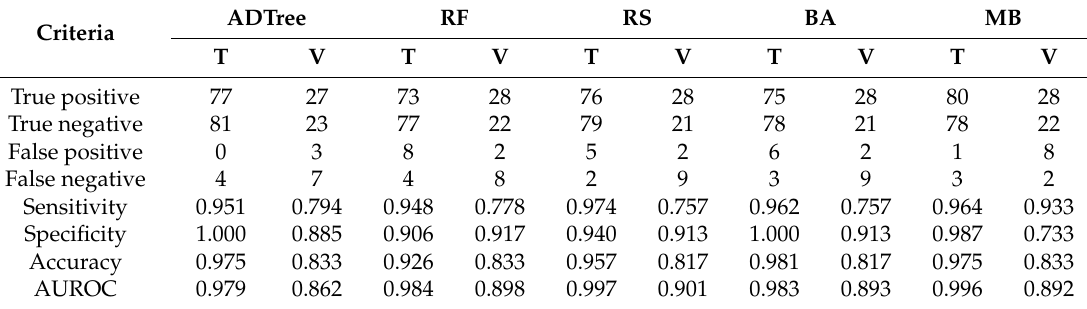
Table 7. Results of ensembles modeling by combination of 60%/40% and raster resolution of 10 m. Criteria